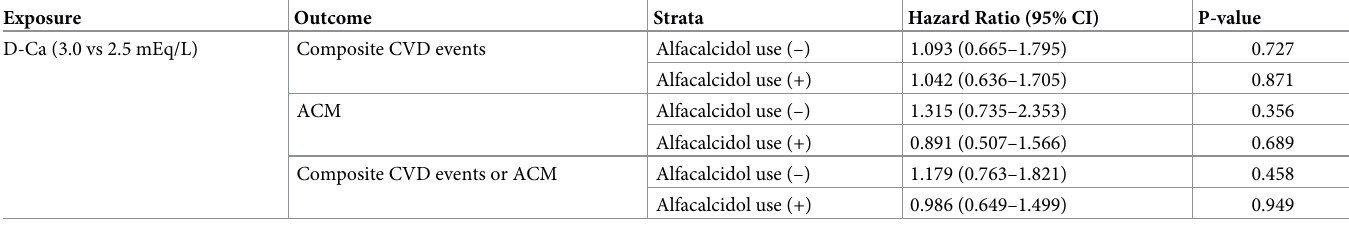
Table 3. Estimated association of dialysate calcium concentration with the two outcomes stratified by use of alfacalcidol.